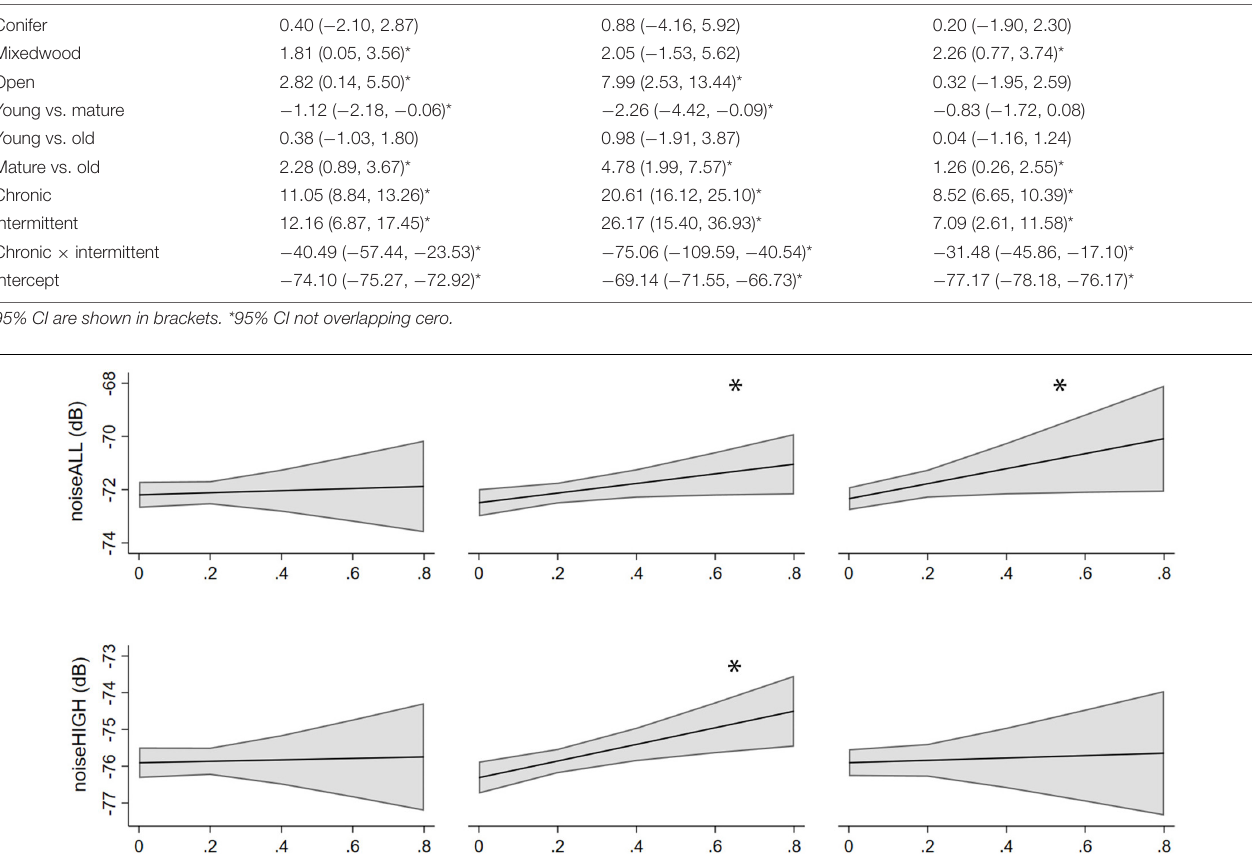
TABLE 4 | Model parameters from the best-fitting models that predict the three different noise metrics as a function of vegetation and energy footprint variables. noiseALL noiseLOW noiseHIGH